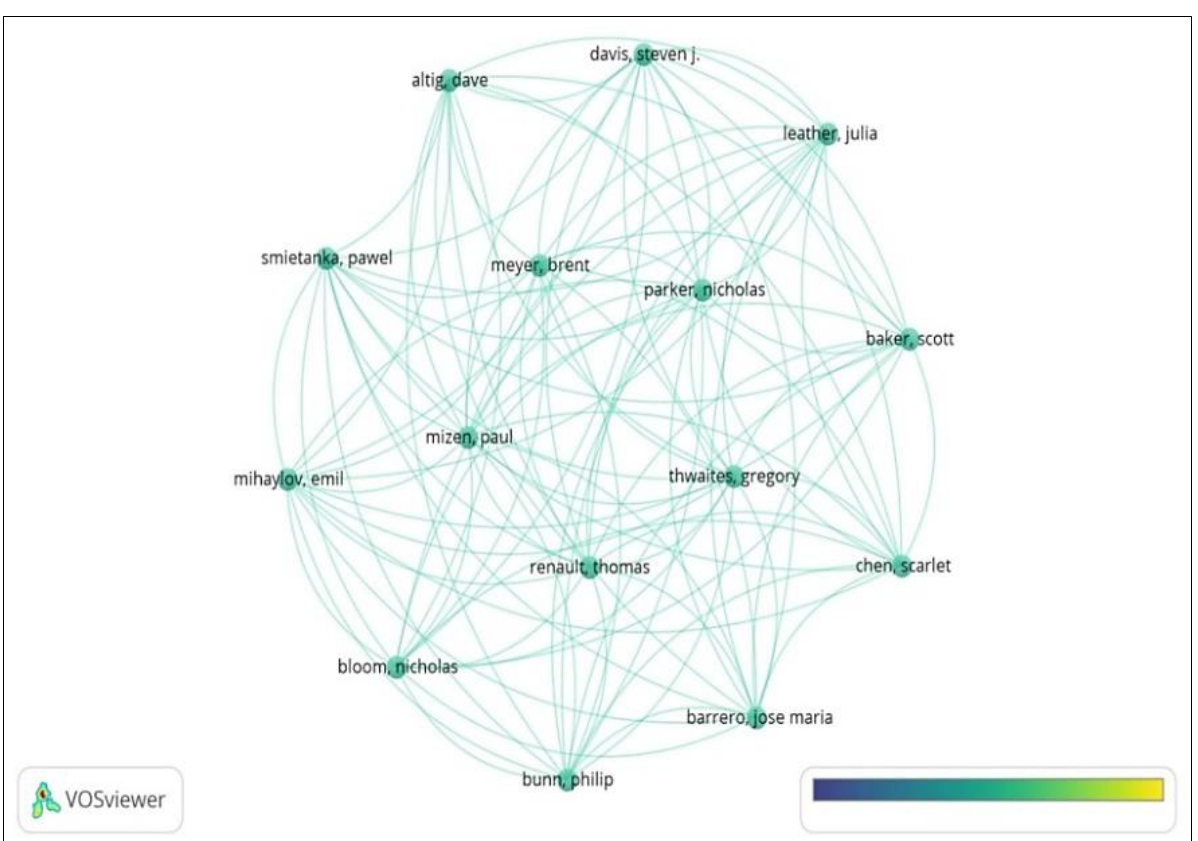
Figure 4. Overlay Visualization of connected